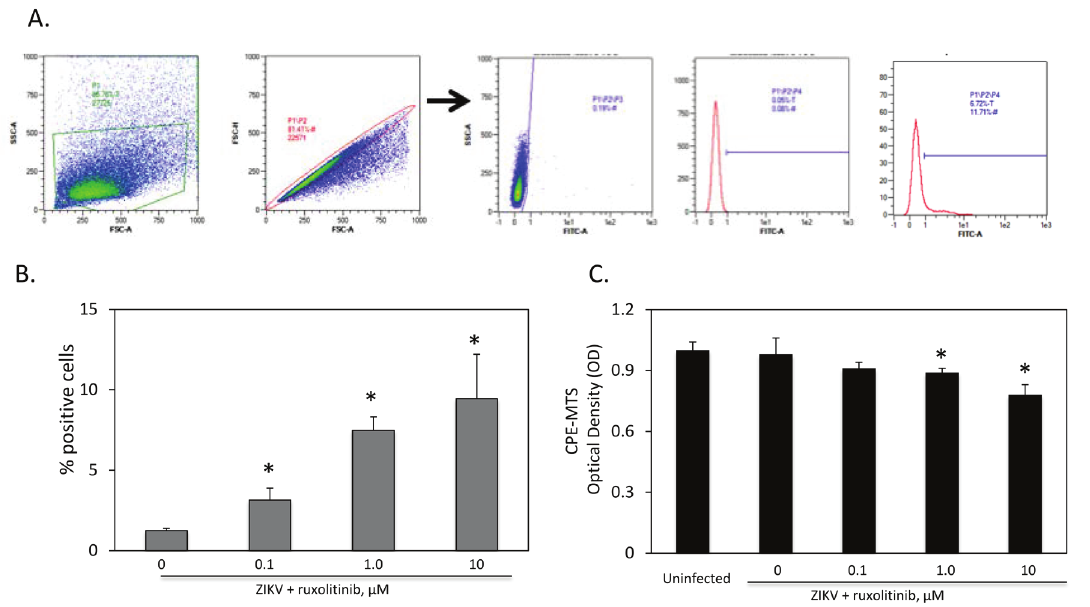
Figure 4. Jak 1/2 inhibitor ruxolitinib significantly increases ZIKV+ cells and virally induced CPE in human neuroblastoma cells. U251 human neuroblastoma cells were infected with MOI 0.5 PRVABC59 for 2 hr +/- 24 hr ruxolitinib pre treatment that was maintained throughout duration of infection. CPE and FACS measured day 5 post infection, after visual monitoring daily for CPE induction. Flow cytometry gating strategy, A; 4G2+ cells, B; Optical Density (OD) values obtained from the MTS assay for virus in- duced cytopathic effect (CPE) with ZIKV PRVABC59, C. * indicates significant difference versus no drug controls, P < 0.05, One way